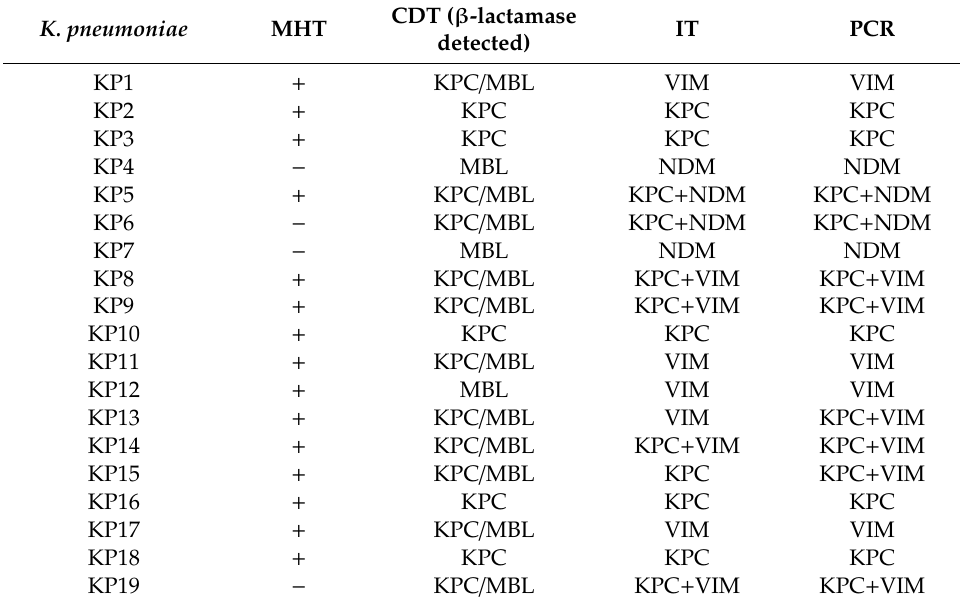
Phenotyping screening and carbapenemases detection in K.pneumoniae strains by immunochromatographic rapid assay and